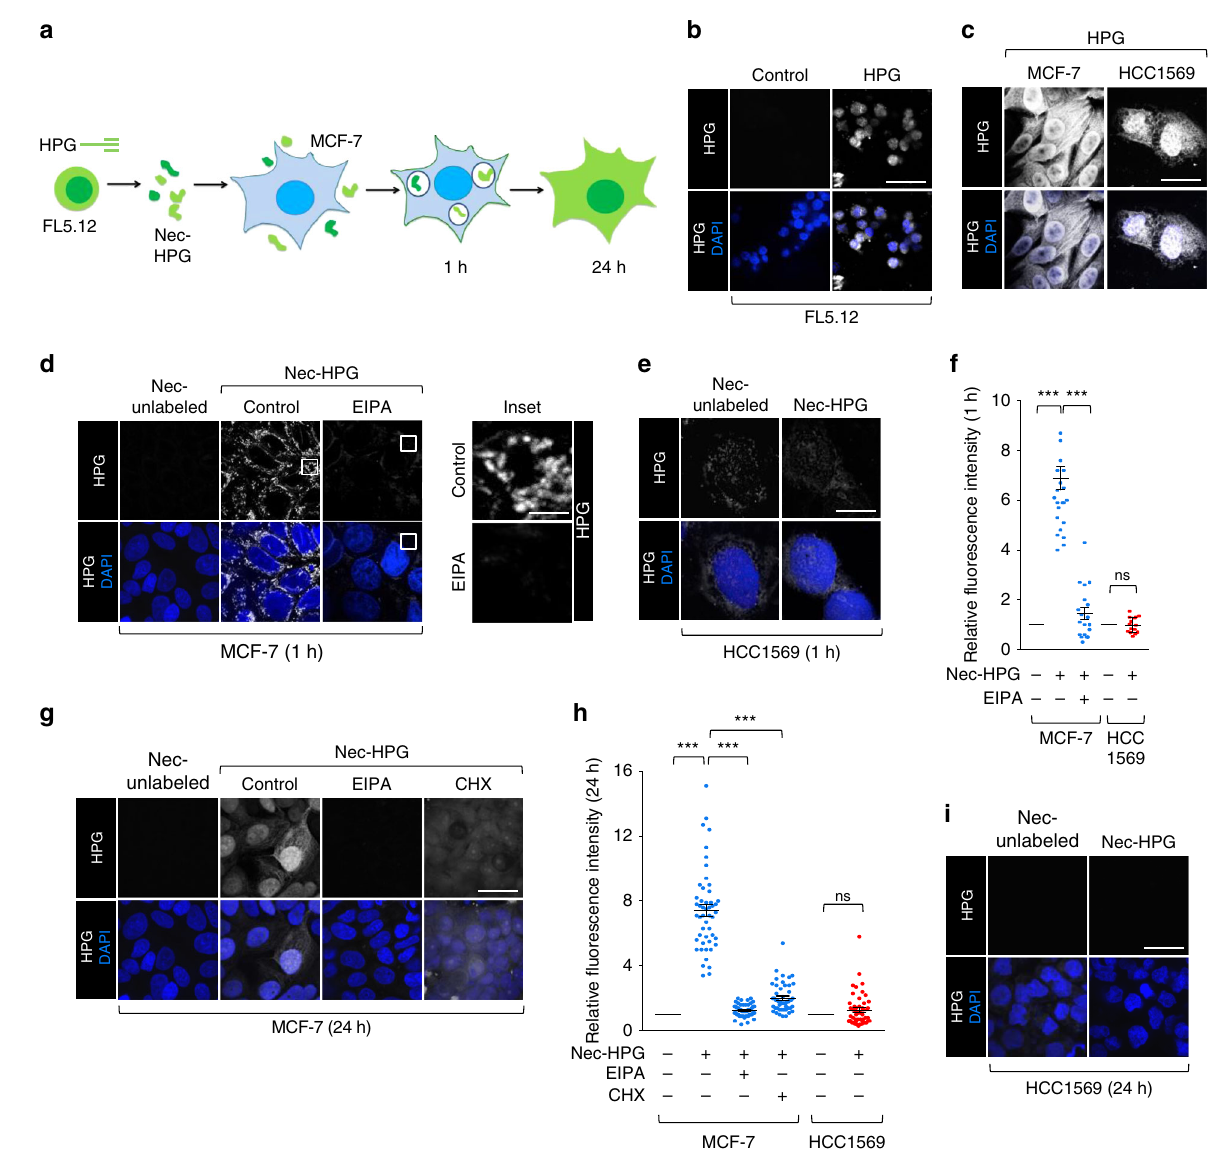
Fig. 2 Measurement of macropinocytic protein fl ux in breast cancer cells. a Assay schematic. FL5.12 cells were labeled with HPG prior to the induction of necrosis. HPG-labeled necrotic debris was added to macropinocytic MCF7 cells for 1 or 24 h. HPG incorporation into the MCF-7 cell proteome was detected with clickable biotin-azide followed by streptavidin-Alexa488. b FL5.12 cells were labeled with HPG for 24 h in complete medium. c MCF-7 or HCC1569 cells labeled as in b but in 1% AA medium. d , e MCF-7 ( d ) or HCC1569 ( e ) cells in 1% AA medium were supplemented with unlabeled or HPG- labeled necrotic cell debris (nec-HPG) for 1 h. MCF-7 cells ± EIPA (50 μ M). f Integrated fl uorescence intensity per cell in d , e normalized to cells fed unlabeled necrotic debris. A total of 25 cells (MCF-7) or 20 cells (HCC1569) from one biological replicate. g As in d but evaluated at 24 h ± EIPA or ± cycloheximide (50 μ g/ml). h Integrated fl uorescence intensity per cell from ( g , i ) normalized to cells fed unlabeled necrotic debris; 50 cells were